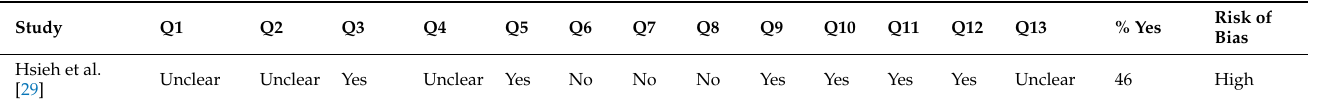
Table 8. Risk of bias assessment for randomized controlled trials according to the JBI tool